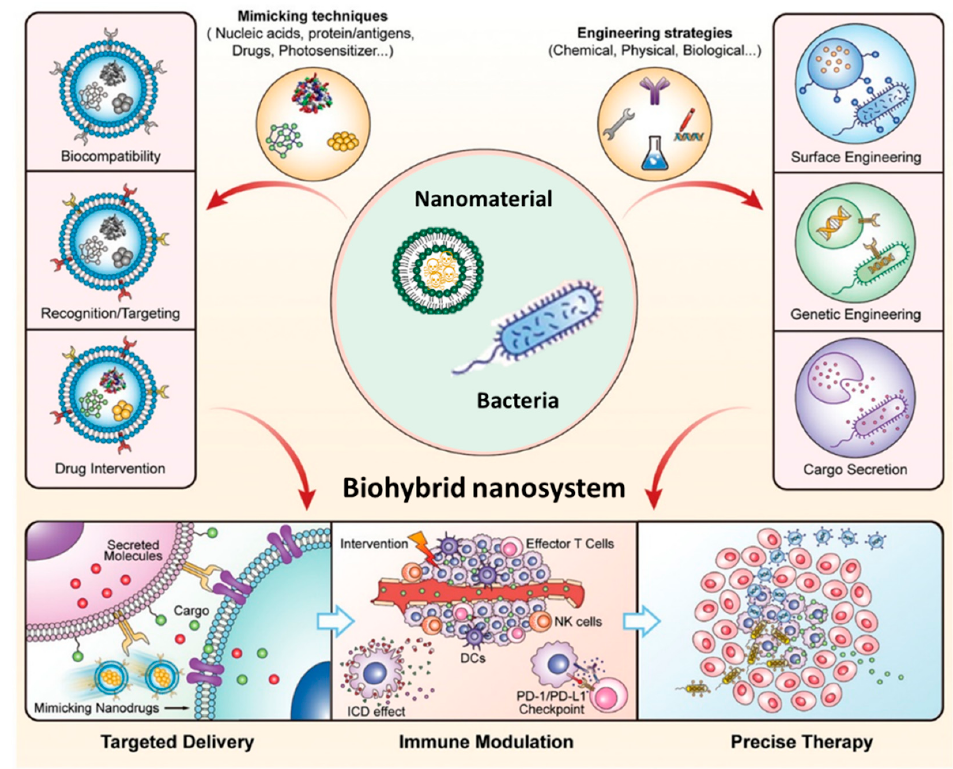
Figure 3. Schematic summary of the main characteristics of BMTT and the different approaches for the obtention of biohybrid nanomaterials based on bacteria for the targeted delivery of payloads, immune system modulation, or precise therapy against cancer. Reproduced with permission from Ref. [93], Advanced Materials, 2021. Copyright © 2021, Wiley -VCH GmbH.